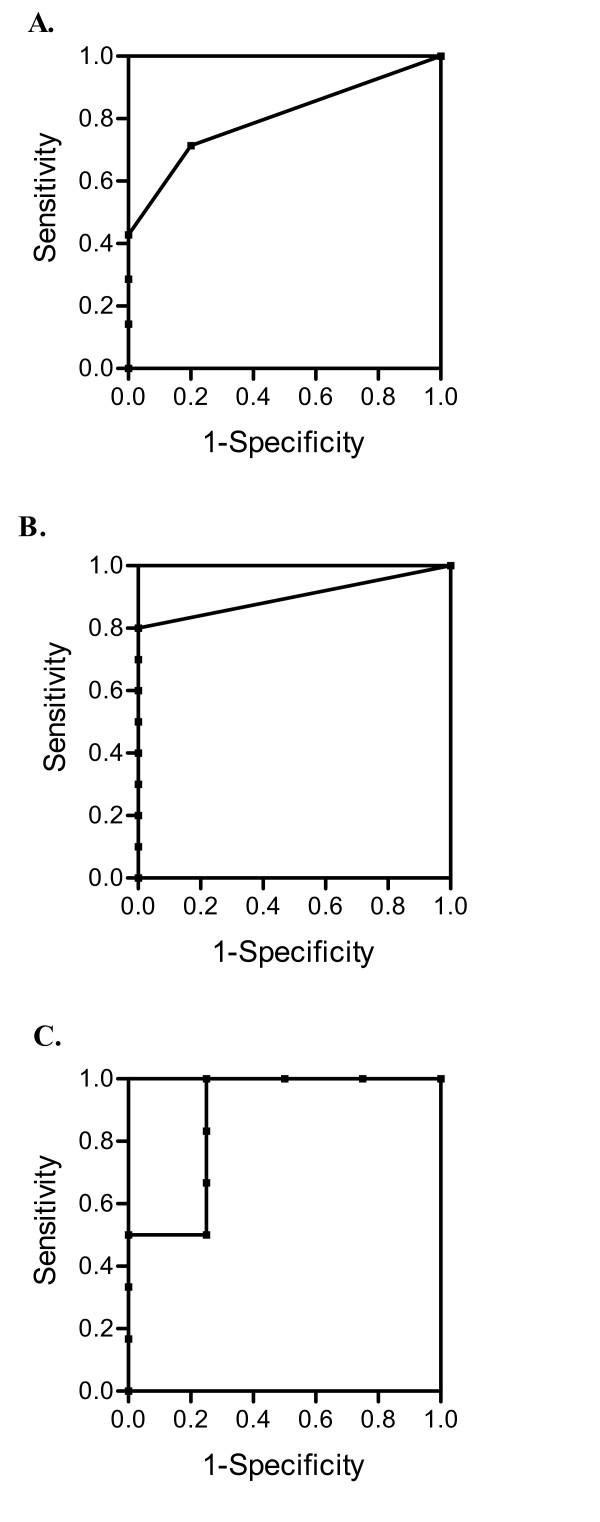
IFN-gamma secretion as measured by ELISPOT accurately detects robust T cell immunity. ROC curves were plotted to assess the diagnostic performance of the ELISPOT assay for (A) HER-2/neu ICD specific cellular immunity (n = 18), (B) tt specific cellular immunity (n = 12), and (C) CMV specific cellular immunity (n = 12). Samples with antigen specific circulating antibodies were considered to have positive immunity.